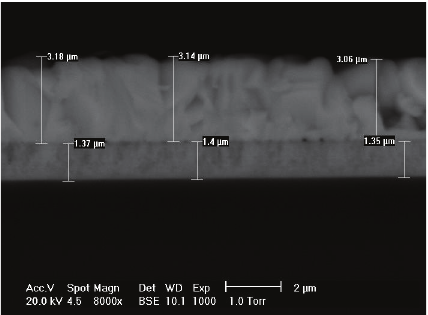
Figure 3: SEM image of a cross-section of the CdTe/CdS/CIO/glass heterostructure studied. The CdS layer is not appreciated because its thickness is of 200 nm. Layer on the top corresponds to CdTe and the lower one to